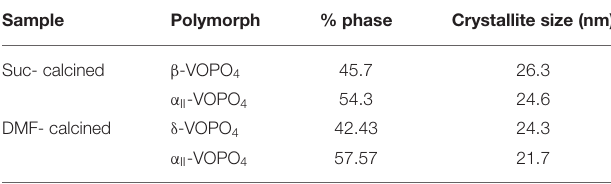
TABLE 1 | Phase content and crystallite sizes for FSP VOPO 4